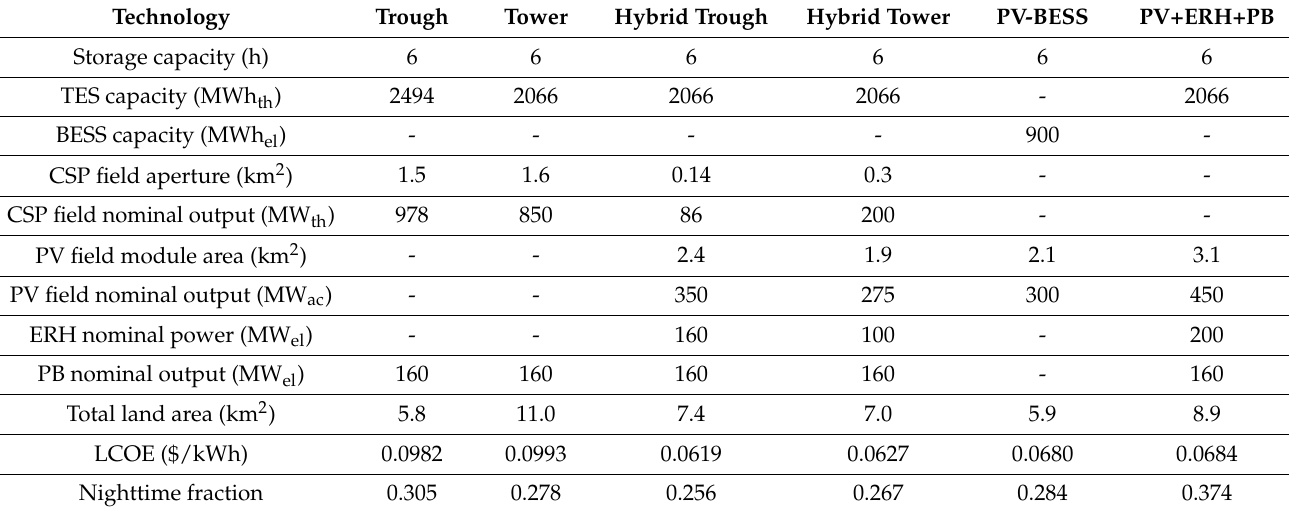
Table 5. Parameters of the six-hour optimized